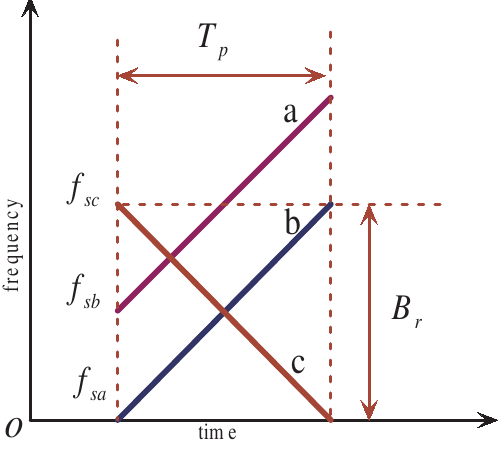
Figure 6. Illustration of three waveforms with overlapped